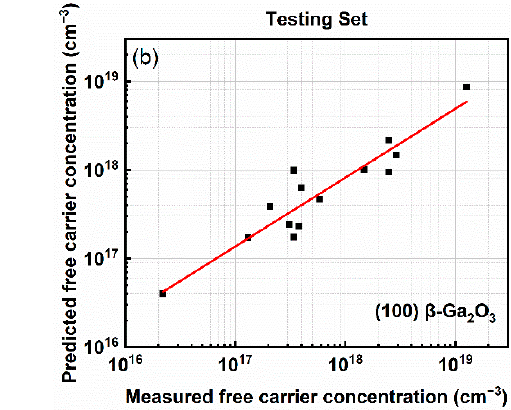
Figure 3. The plot of the predicted doping level versus the measured free-carrier concentration from (100) β -Ga 2 O 3 thin films using the trained fDNN: ( a ) Training set and ( b ) Testing set.